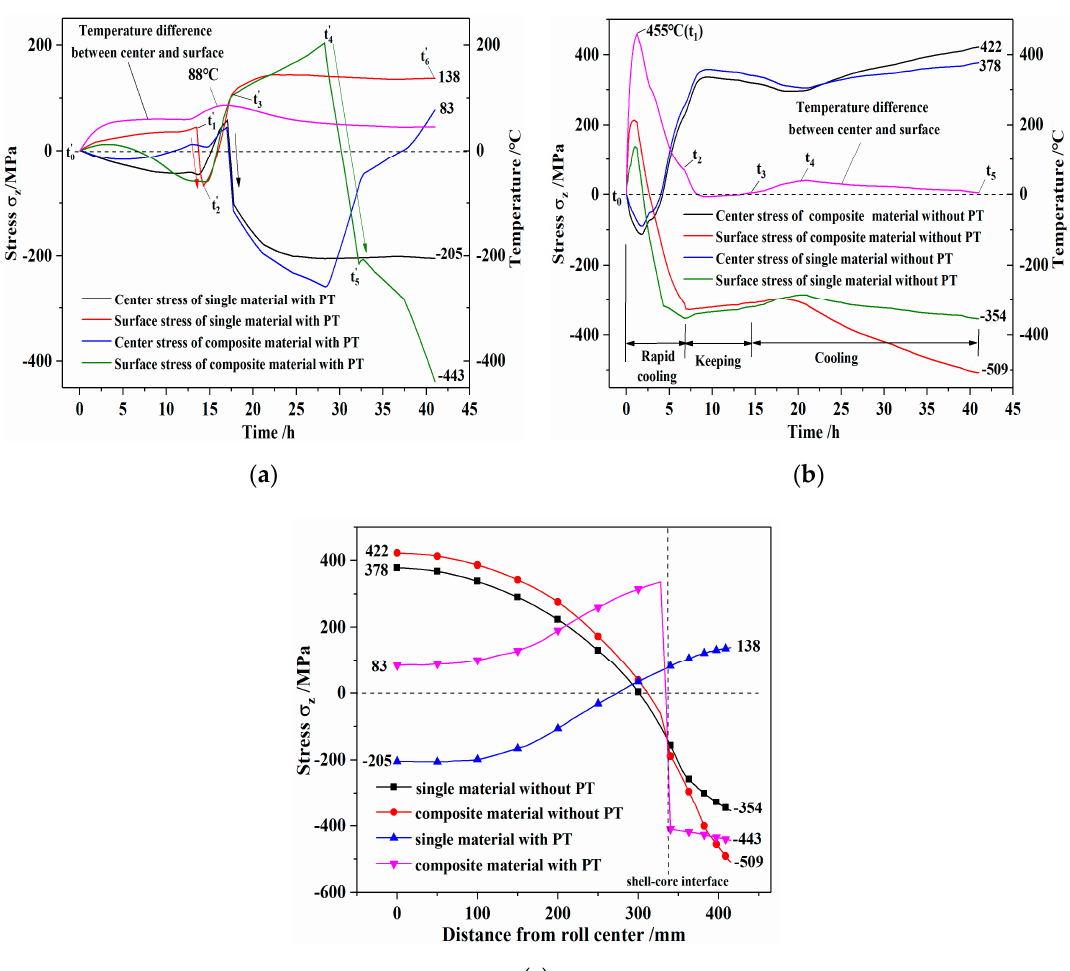
Figure 2. History and distribution of residual stress in the HSS work roll during quenching: ( a ) thermal stress; ( b ) transformation stress; ( c ) distribution of the thermal stress and transformation stress.